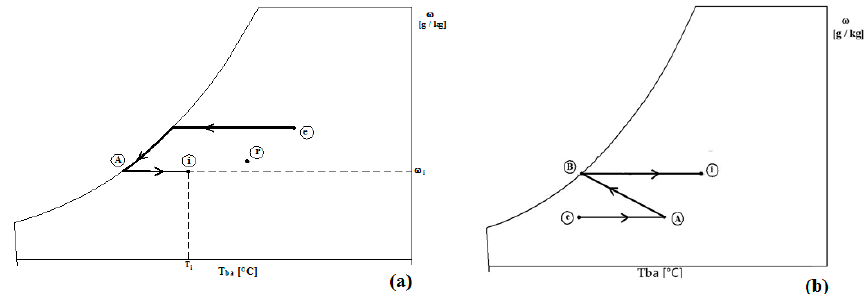
Figure 4. Processes of the humid air on the psychometric chart into the AHU during: ( a ) summer and ( b ) winter.